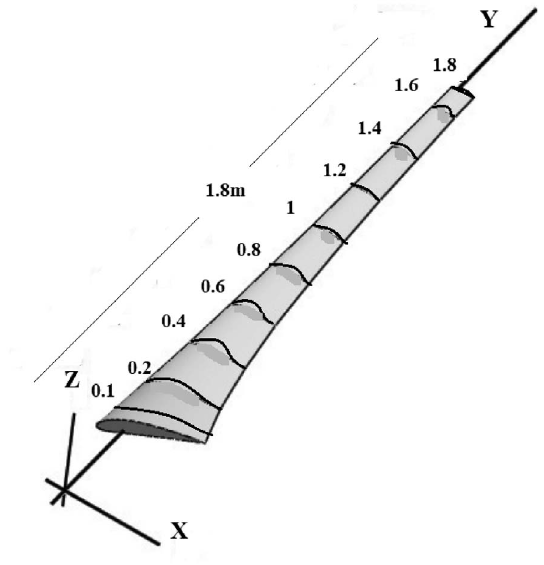
Figure 9. A typical design of blade as outcome of the work.